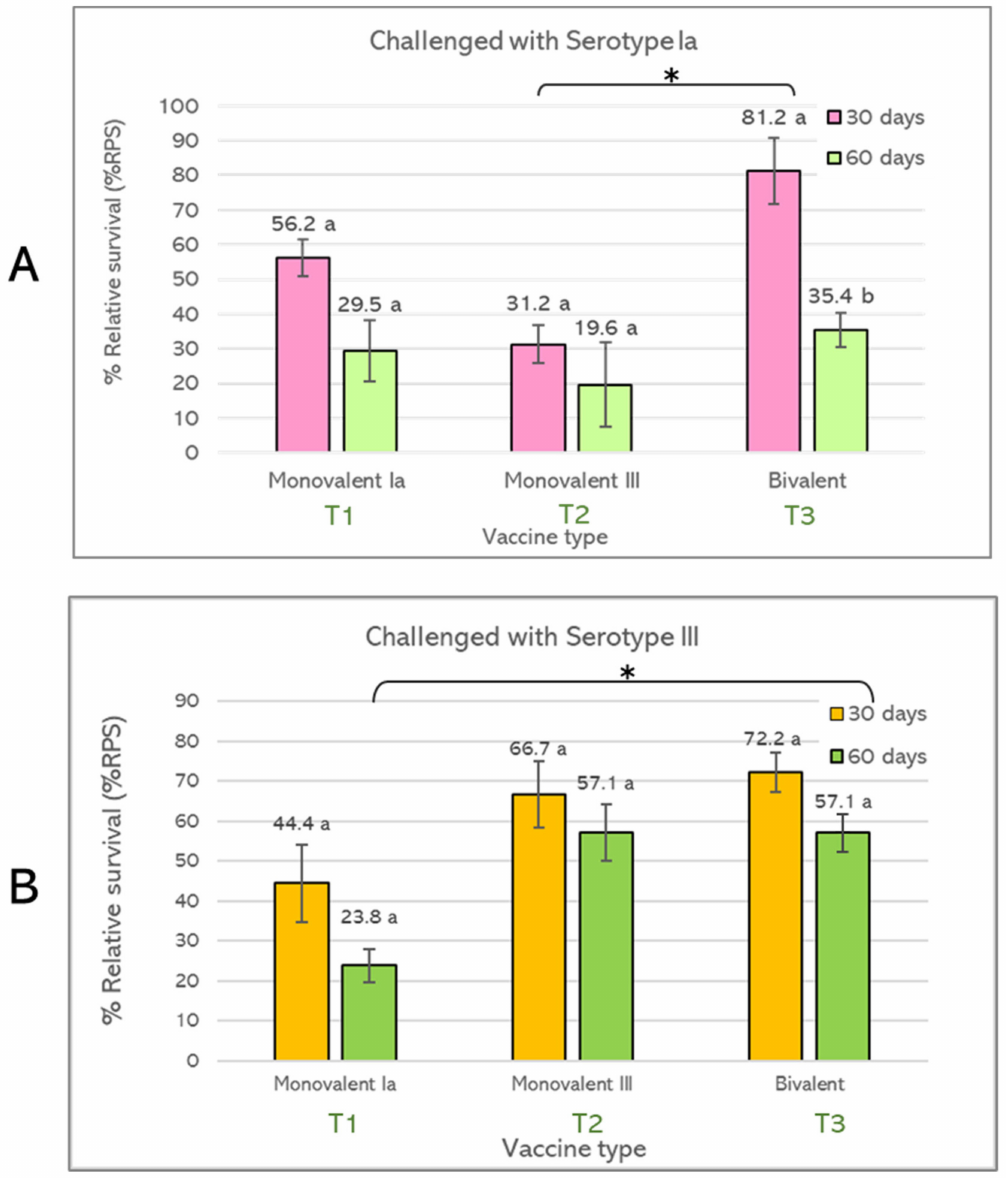
Figure 6. Relative percent survival (RPS) of Nile tilapia ( Oreochromis niloticus Linn.) immunized with monovalent vaccine: serotype Ia (T1); monovalent vaccine: serotype III (T2) and bivalent vaccine (T3), and non-vaccinated (control). After a single shot of vaccination at 30 and 60 days, fish were challenged with S. agalactiae serotypes Ia and III. ( A ) RPS of Nile tilapia challenged with S. agalactiae serotype Ia, ( B ) RPS of Nile tilapia challenged with S. agalactiae serotype III. ( n = 30). a, b = significant difference between 30 and 60—days ( p < 0.05) and asterisk (*) = significant difference between treatment groups ( p <